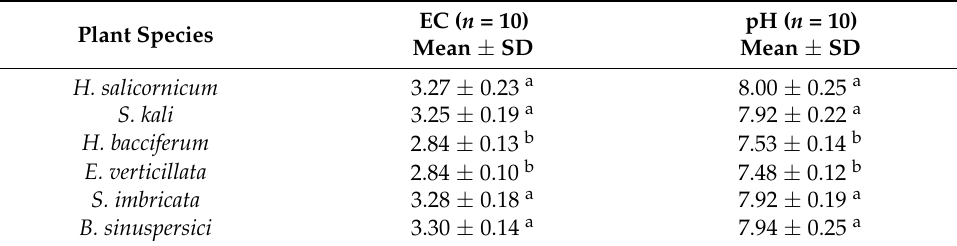
Table 1. Soil electrical conductivity (EC) and pH of the six wild plant hosts. The mean EC and pH of the six wild plant hosts. The lower case letters on the numbers refer to the significance level. Different letters refer to significant differences and the same letters refer to insignificant differences at p < 0.05 using LSD post hoc tests.